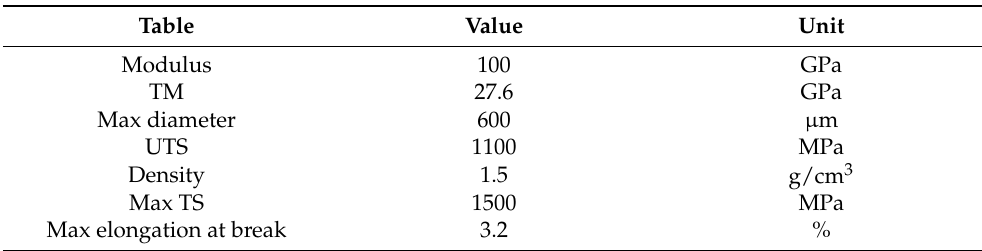
Table 1. Flax fiber traits. TS stands for tensile strength and UTS for ultimate tensile strength. Data retrieved from Vaisey-Genser and Morris, 2003